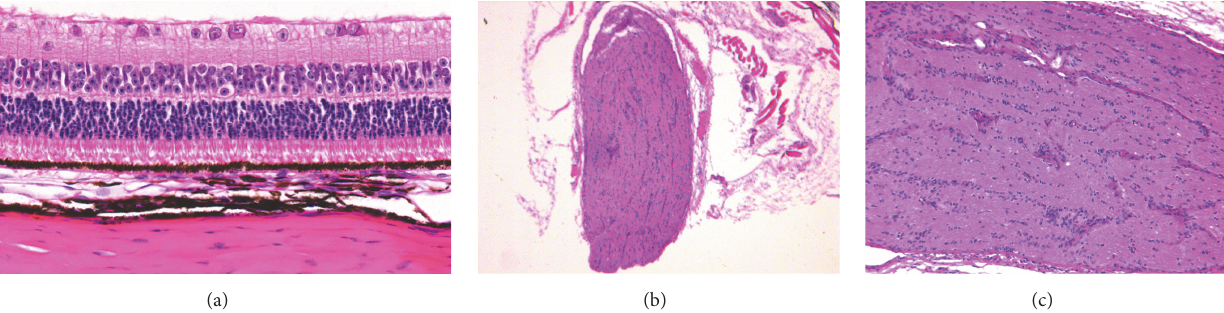
Figure 6: Intact retina and optic nerve in a glyceraldehydes treated eye. (a) The retina was without abnormalities (H&E stain; original magnification -400). ((b) and (c)) The optic never was intact (H&E stain; (b) original magnification -40; (c) original magnification -100). However, when compared to normal control eyes, there were no significant differences between the groups at all strain levels (Table